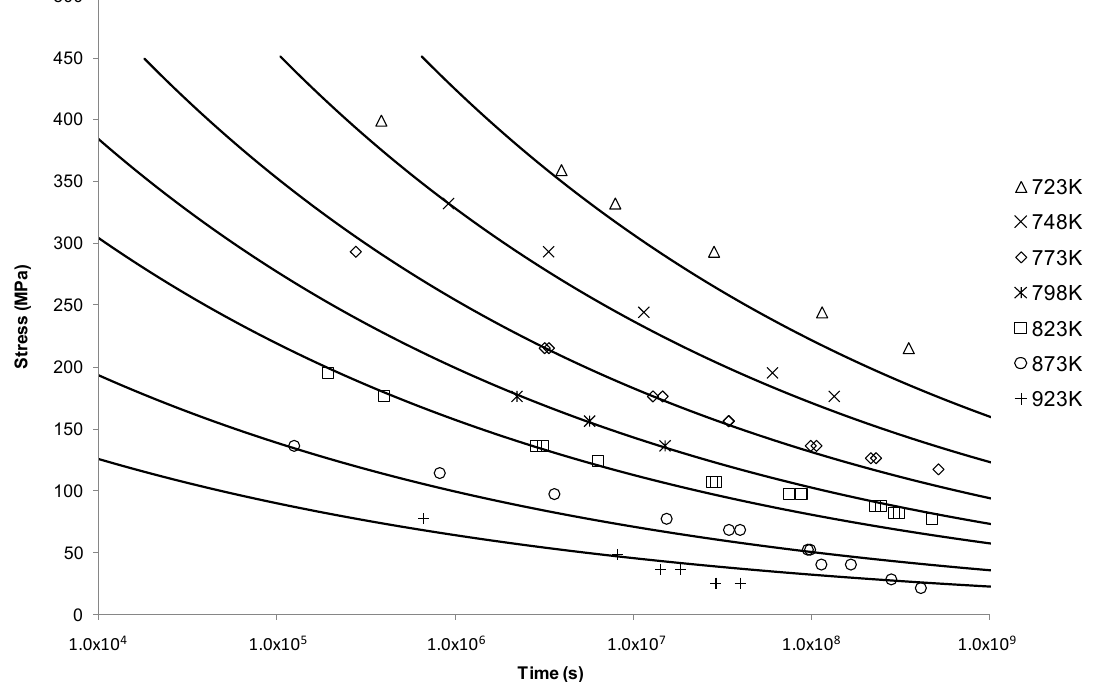
Figure 7. The stress vs . time to fracture curves of Soviet Model 1 using Grade 22 Steel creep